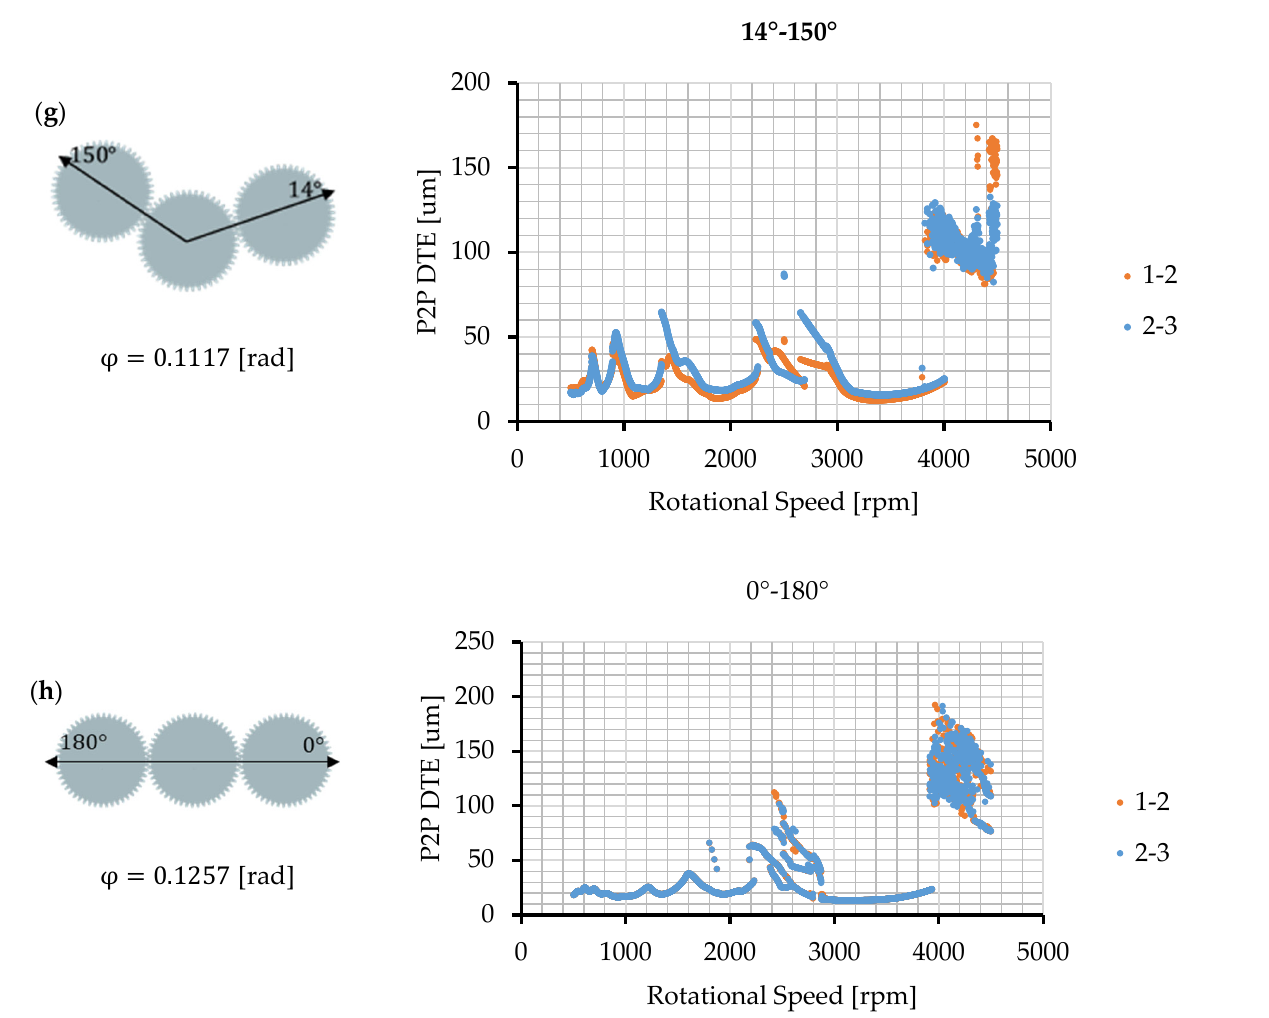
Figure 10. DTE results in different gear positions. ( a ) 40–150°. ( b ) 40–180°. ( c ) 0–90°. ( d ) 16–150°. ( e ) 30–150°. ( f ) 15–150°. ( g ) 14–150°. ( h ) 0–180°. The phase difference between gears coming into contact directly changes the